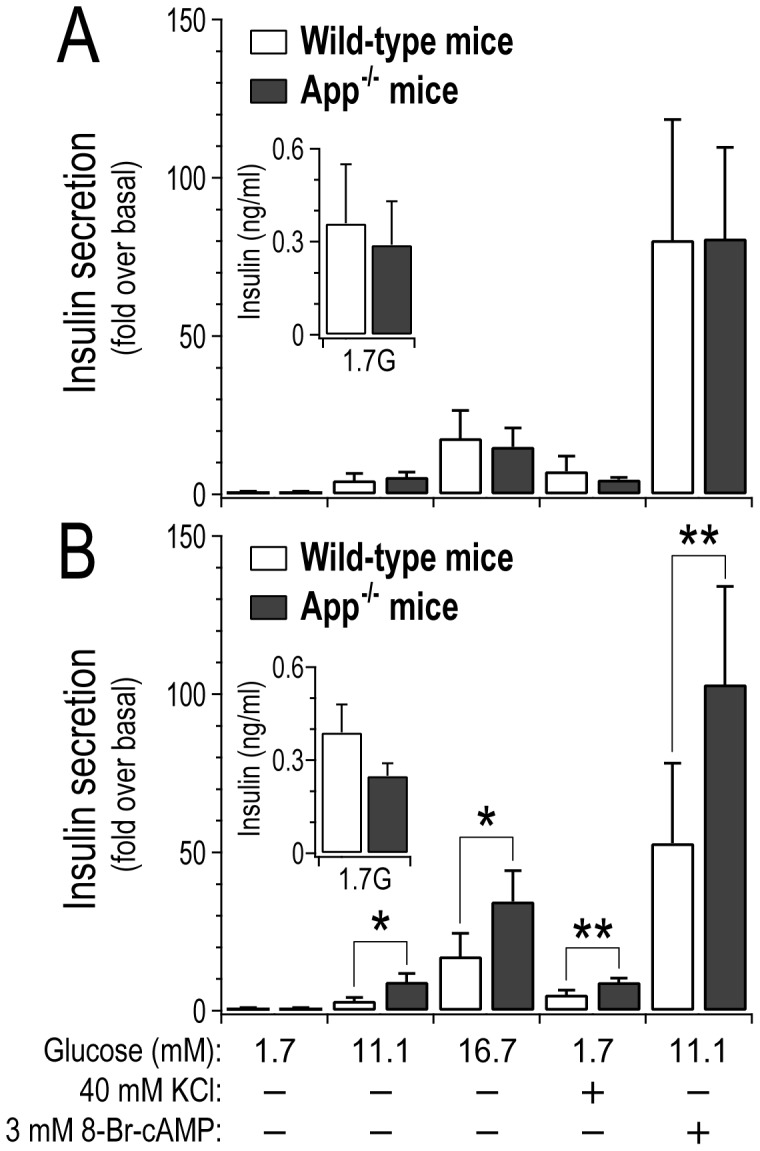
Loss of App leads to increased insulin secretion from islets in older mice.Islets were collected from 10 week old (A) or 17 week old (B) male wild-type or whole-body App−/− mice. Insulin secretion was stimulated by varying glucose concentrations, a depolarizing concentration of KCl, or 8-Br-cAMP, a membrane-permeant analogue of cAMP. Data expressed relative to secretion observed in response to 1.7 mM glucose, 4.7 KCl and no cAMP (basal). *, p<0.05; **, p<0.01 for App−/− versus wild-type mice. Inserts show average basal insulin secretion (ng/ml) from 3 islets per genotype in response to 1.7 mM glucose (n = 3 for each experimental group).